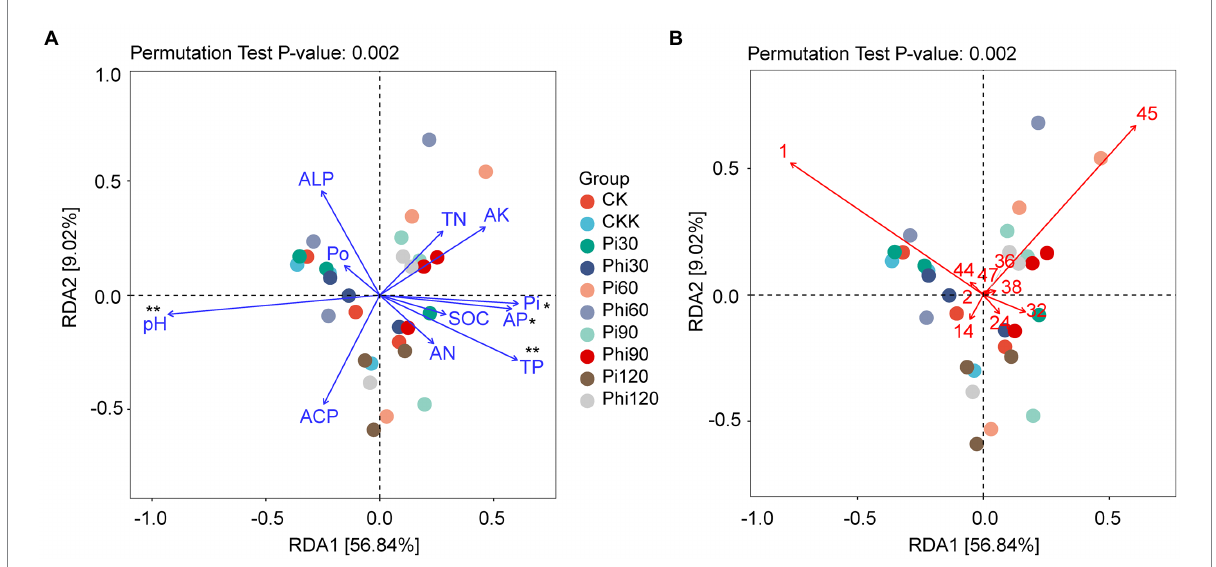
FIGURE 5 The redundancy analysis (RDA) plot showing the relationships between environmental factors and the OTUs profiles of the phoD - harboring bacterial community. (A) Significant properties exhibited in RDA. (B) Significant family microorganisms exhibited in RDA. The blue lines represent the environmental variables, and the colored dots denote soil samples from the different fertilizer treatments. See Figure 2 for the defined abbreviations. ( B) The number represents family name, 1, unassigned family; 2, Vicinamibacteraceae; 14, unclassified family; 24, unclassified family; 32, Acetobacteraceae; 36, unclassified family; 38, Comamonadaceae; 44, Pseudomonadaceae; 45, Xanthomonadaceae; 47, unclassified family. Phi represents phosphite fertilizer; Pi denotes phosphate fertilizer. The values 30, 60, 90, and 120 represent the treatment concentrations. The asterisk “*” represents significant relationships ( p < 0.05), while the double asterisk “**” represents highly significant relationships ( p <